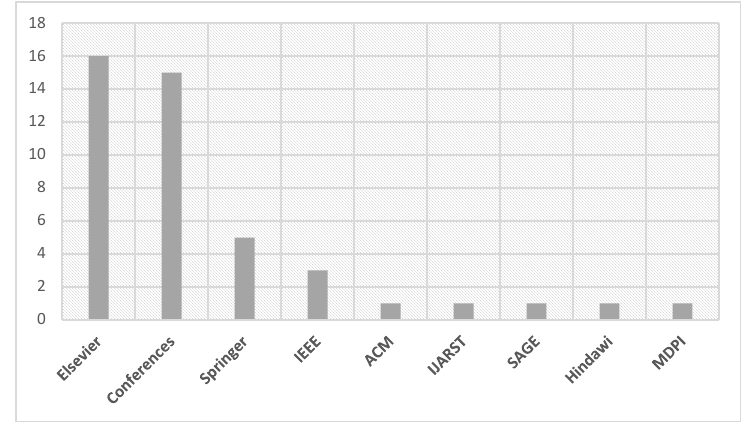
Figure 4. Number of papers reviewed in this study for each publisher.